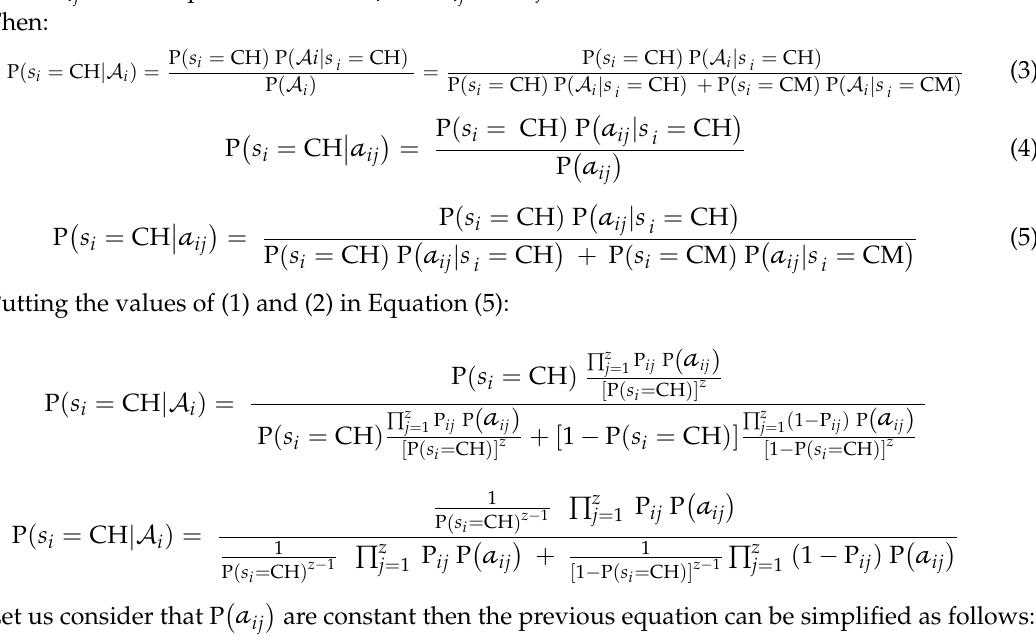
Figure 4. Dynamic clustering scheme.